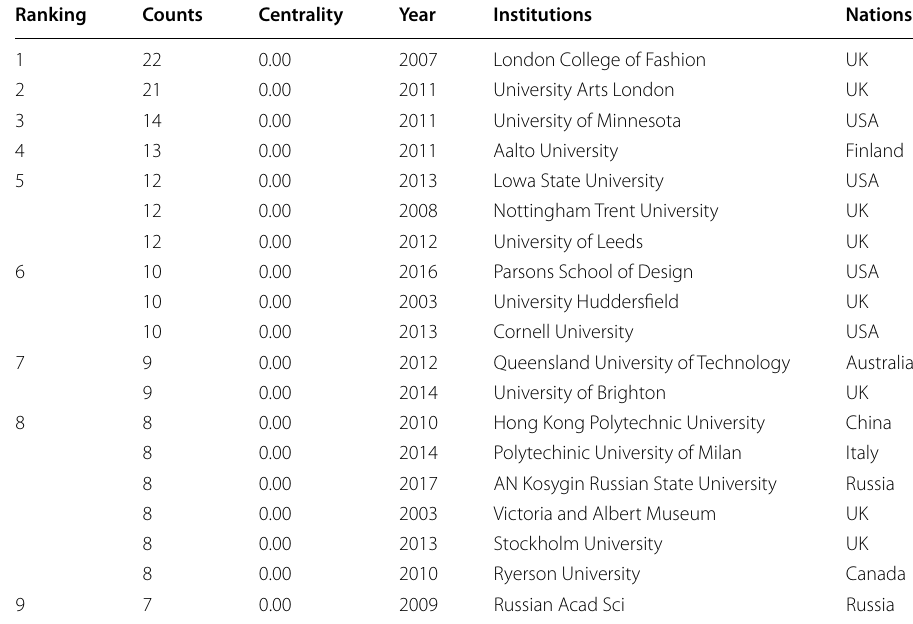
Table 2 Top 10 productive institutions of “fashion design” related articles